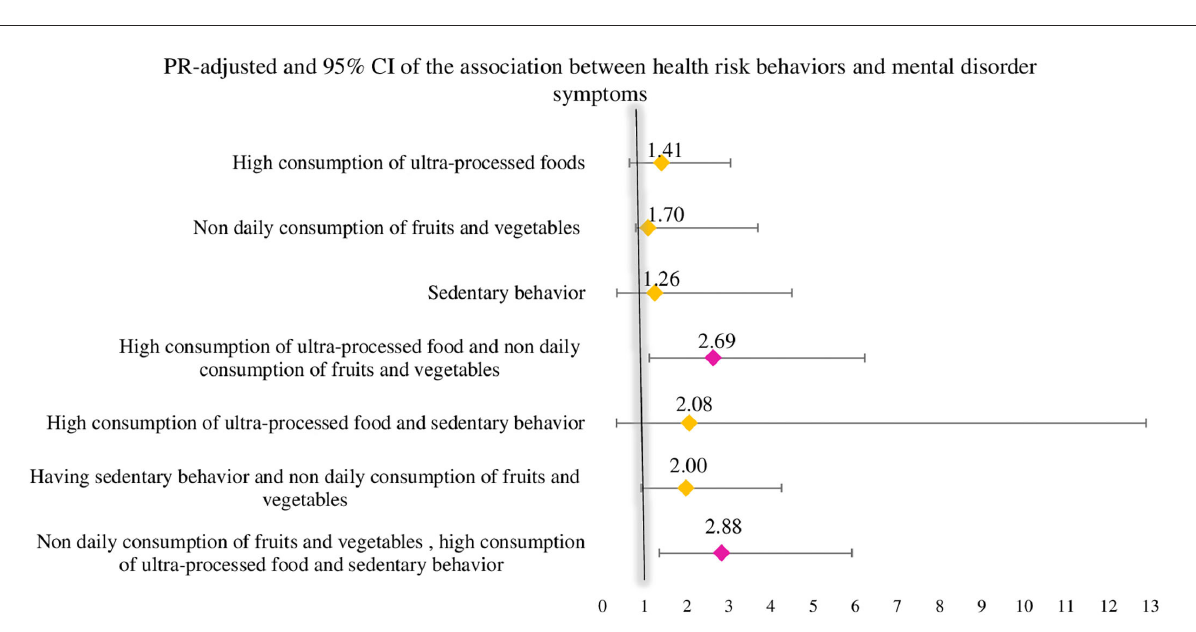
FIGURE4 Prevalence ratio and 95% confidence interval (CI) for the interaction analysis between the co-occurrence of health risk behaviors and the presence of symptoms of mental disorder, COVID Inconfidentes 2020. Combined analysis to verify the existence of an association between the outcome (presence of depression or anxiety symptom) and the explanatory variables, given as health risk behaviors sedentary behavior, non-daily consumption of fruits and vegetables, and high weekly consumption of ultra-processed foods. The analysis was adjusted for sex, age, family income, having a job, and